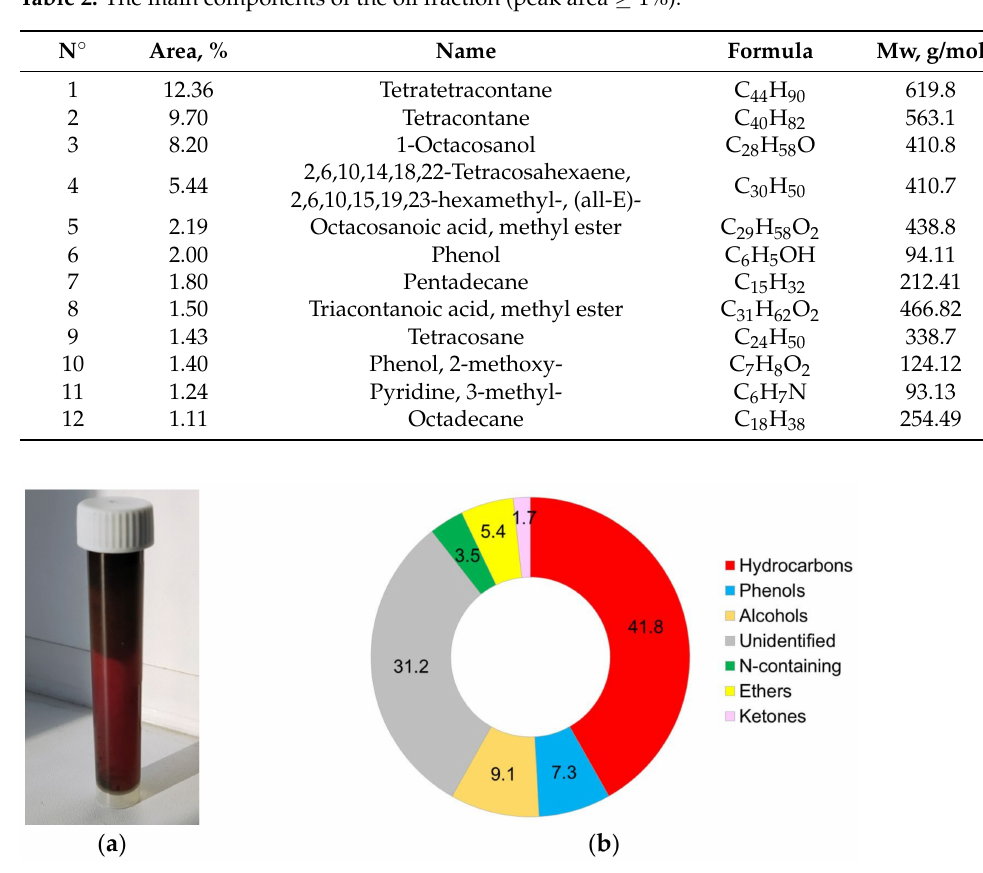
Figure 1. AIW pyrolysis products. Table 2. The main components of the oil fraction (peak area ≥ 1%).